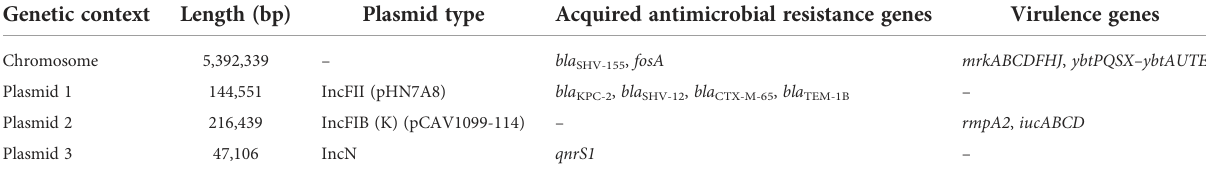
TABLE 4 Genome characteristics of isolate